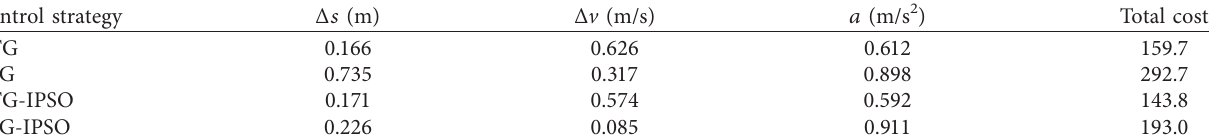
Table 2: The root-mean-square value of performance indicators.